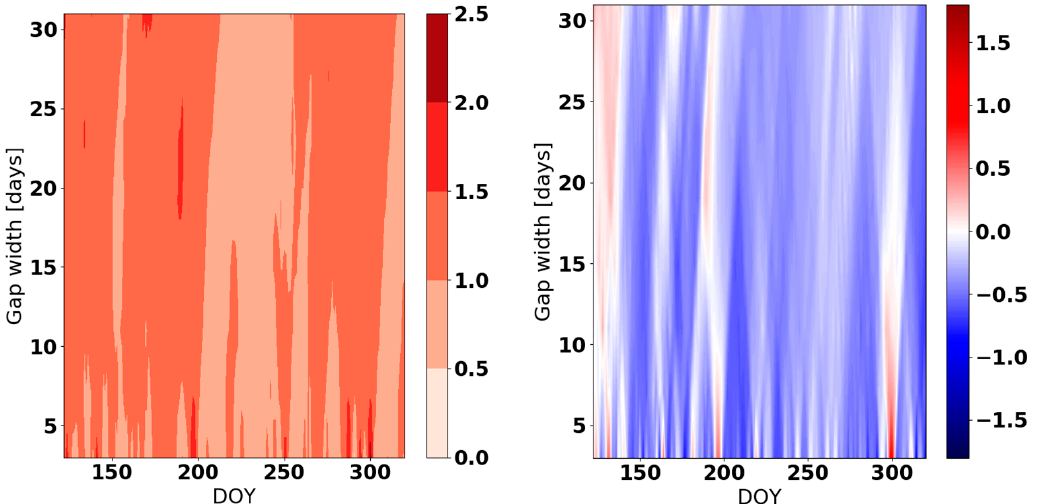
Figure 14. Standard deviation of the observed data which were used for bias correction for the islands of Montecristo ( left panel ) and Pianosa ( right panel ) for the DOY 122–320 in 2016.